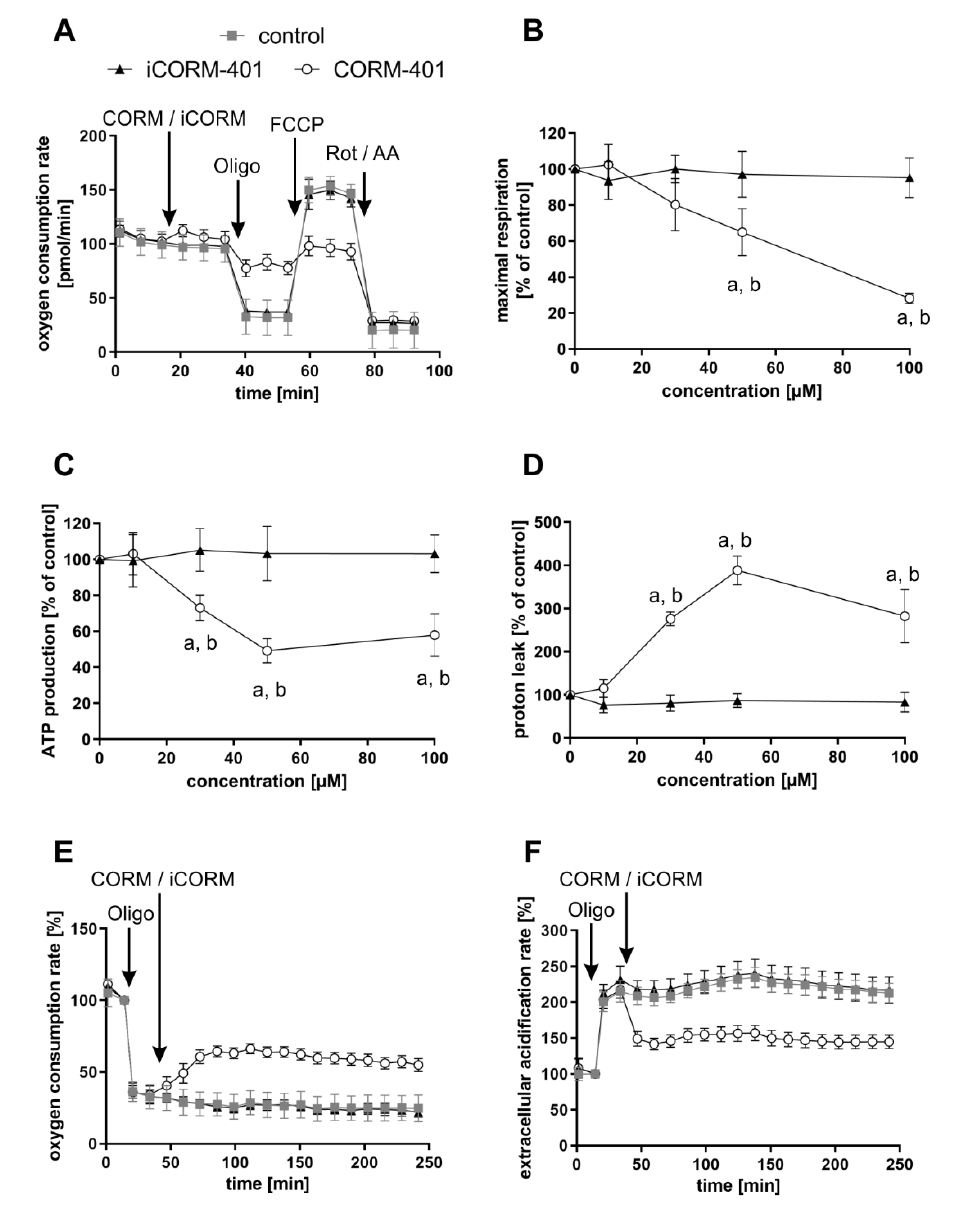
Figure 2. Modulation of mitochondrial respiratory parameters by CO results in a specific e ff ect pattern. CORM-401 and iCORM-401 were injected into reaction wells and the mito stress test (sequential injection of oligomycin, FCCP, and rotenone + antimycin A) was performed. Injections are indicated by arrows. Representative OCR curves are given ( A ) with the final concentration of CORM-401 / iCORM-401: 50 µ M. Data represent mean ± SD of at least six technical replicates. Quantification of the mitochondrial respiratory parameters maximal respiration ( B ), ATP production ( C ), and proton leak ( D ) is shown for 10–100 µ M CORM-401 / iCORM-401. Data represent mean ± SD of three independent experiments (n = 3). In a modified experimental setting, first oligomycin and then 50 µ M CORM-401 or iCORM-401 were applied and OCR ( E ) and ECAR ( F ) were monitored over time. Representative OCR and ECAR curves of three independent experiments are shown. Data represent mean ± SD of at least six technical replicates. OCR = oxygen consumption rate, ECAR = extracellular acidification rate, Oligo = oligomycin, Rot / AA = rotenone + antimycin A. Statistical analysis was performed using one-way ANOVA and detailed results are given in Table S1. a: control vs. CORM-401, b: CORM-401 vs. iCORM-401 with p ≤